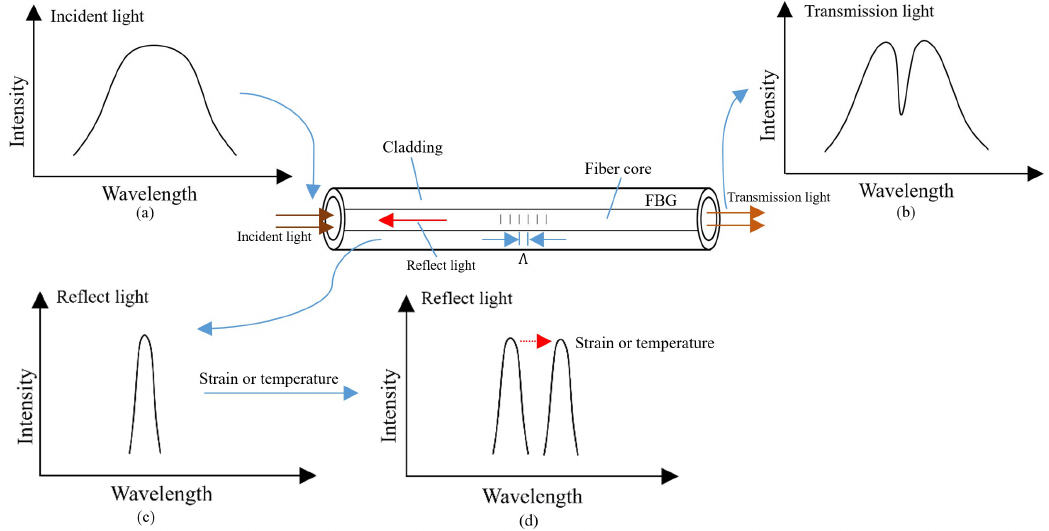
Figure 1. FBG sensing schematic. ( a ) Incident light; ( b ) Transmission light; ( c ) Reflect light; ( d ) Reflected light after FBG is subjected to strain or temperature change.